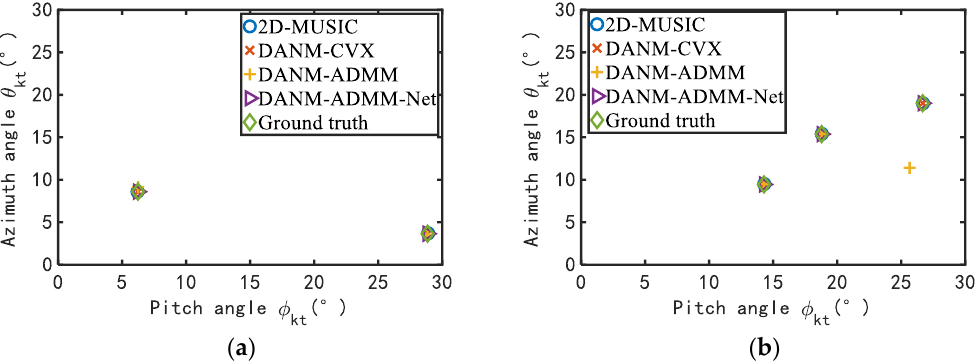
Figure 8. 2D DOA estimation results of different methods. ( a ) Two targets. ( b ) Three targets.